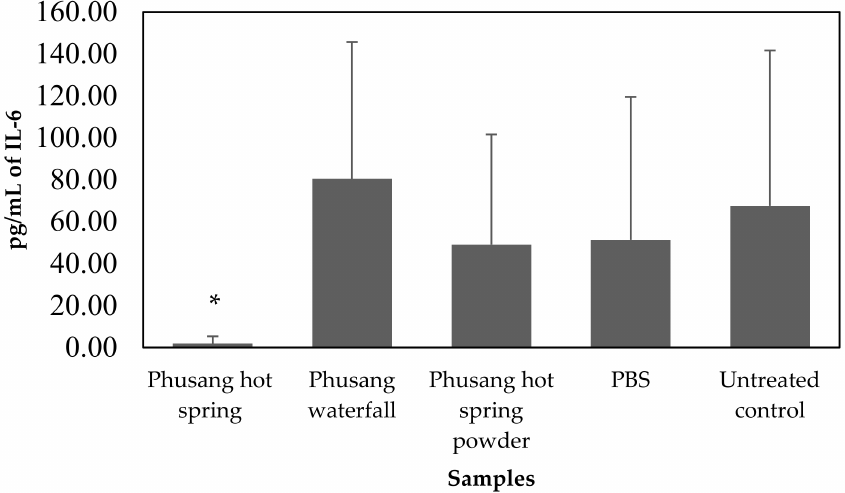
Figure 8. Levels of the IL-6 protein produced by PBMCs at 24 h, as determined using ELISA (* indicates a statistically significant difference between samples).